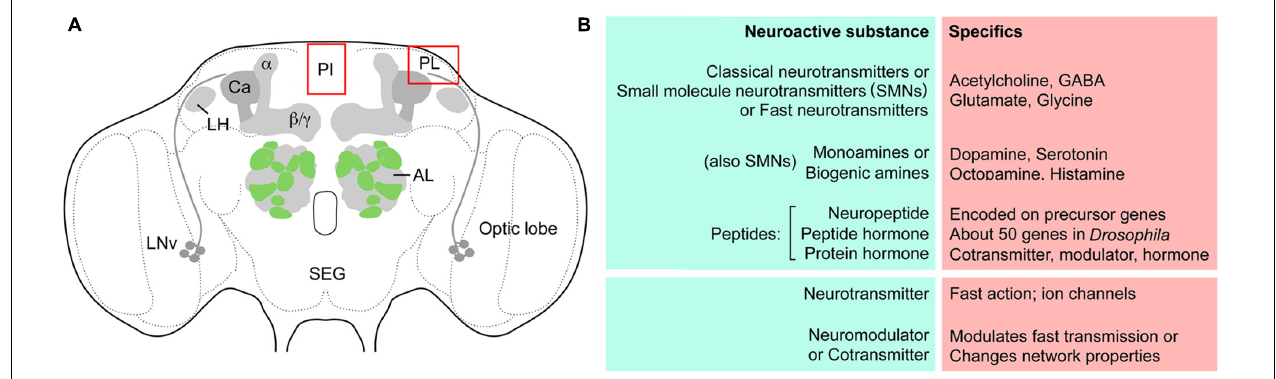
FIGURE 1 | Outline of Drosophila brain centers and some definitions. (A) The adult Drosophila brain with some of the centers/regions discussed in this review. The glomerular antennal lobes (AL) are located anteriorly. Projection neurons from the ALs supply axons to the calyx (Ca) of the mushroom bodies (MBs) and the lateral horn (LH). The MBs have three major lobes, α , β , and γ lobes. Neurosecretory cells are located in the pars intercerebralis (PI) and pars lateralis (PL), as well as in the subesophageal ganglion (SEG). Bilateral pacemaker centers of the circadian clock are located near the optic lobe and are formed by the LNv clock neurons and others not shown. (B) Some definitions of terms used in this review for signaling with neuroactive substances. So-called classical- or SMNs are sometimes referred to as fast neurotransmitters. The four listed ones are discussed in this review. Monoamines or biogenic amines can be subdivided into catecholamines, indolamines and phenolamines, and the four amines discussed here are listed. Neuropeptides/peptide hormones are very diverse and some larger ones are termed protein hormones. Commonly peptides/proteins of this kind act as cotransmitters, modulators or hormones over a slower and more long lasting temporal scale than the neurotransmitters. The neurotransmitters often activate ion channels leading to rapid changes in membrane